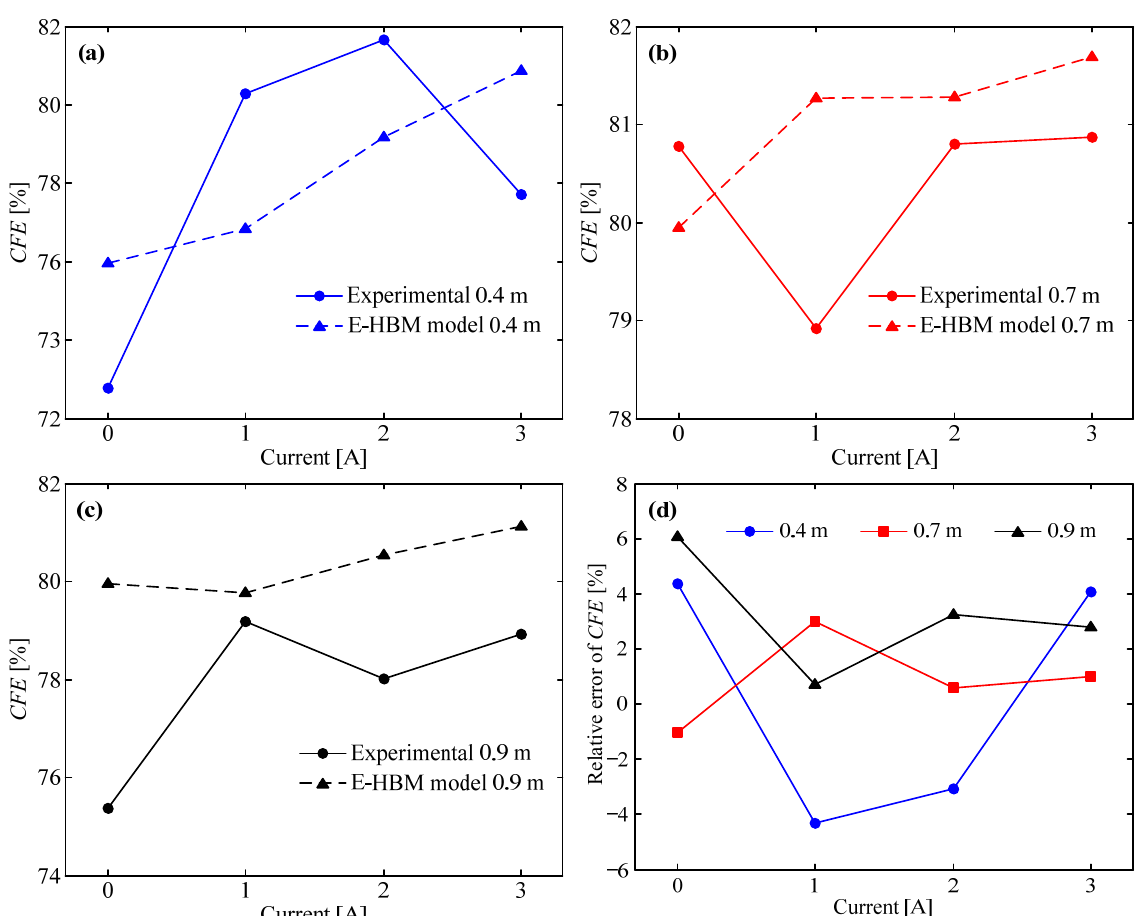
Figure 10. E–HBM model vs. measured data: ( a ) CFE at 0.4 m, ( b ) CFE at 0.7 m, ( c ) CFE at 0.9 m, and ( d ) relative error of CFE at different drop heights.